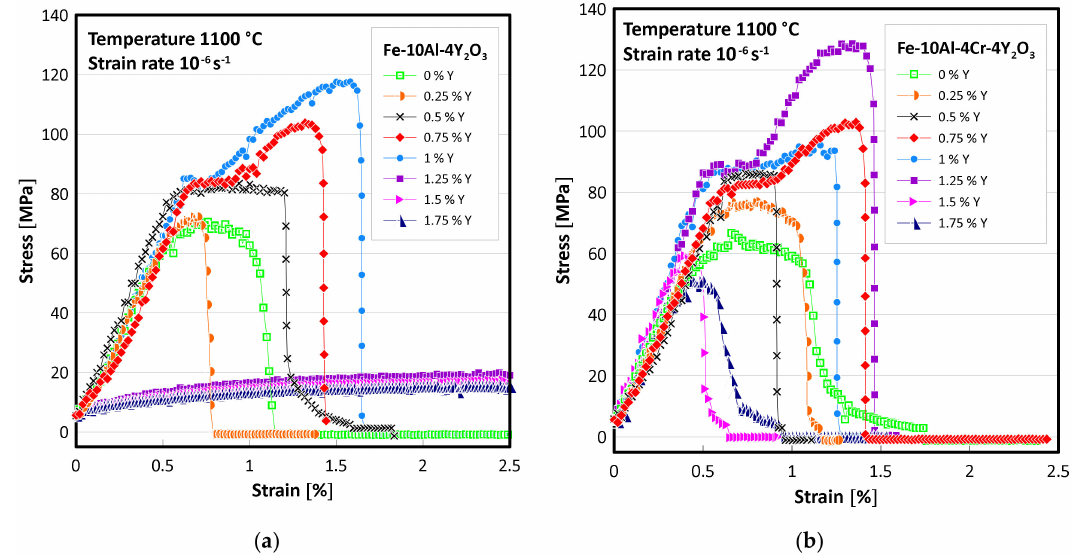
Figure 1. The typical stress-strain curves of ( a ) Fe-10Al-4Y 2 O 3 and ( b ) Fe-10Al-4Cr-4Y 2 O 3 ODS alloys with addition of different amounts of Y.